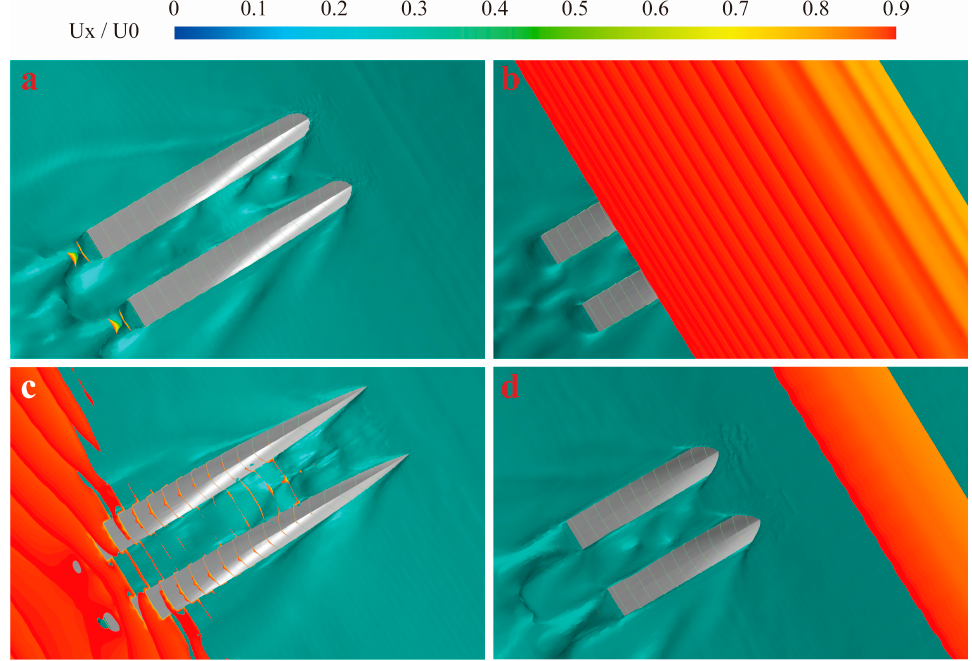
Figure 31. Boundary layer represented by slices colored with dimensionless axial velocity limited to U x /U 0 = 0.9 at 7 level sea state with the 0° wave direction. ( a ) T = 1/4 T 0; ( b ) T = 2/4 T 0; ( c ) T = 3/4 T 0; ( d ) T = 4/4 T 0.